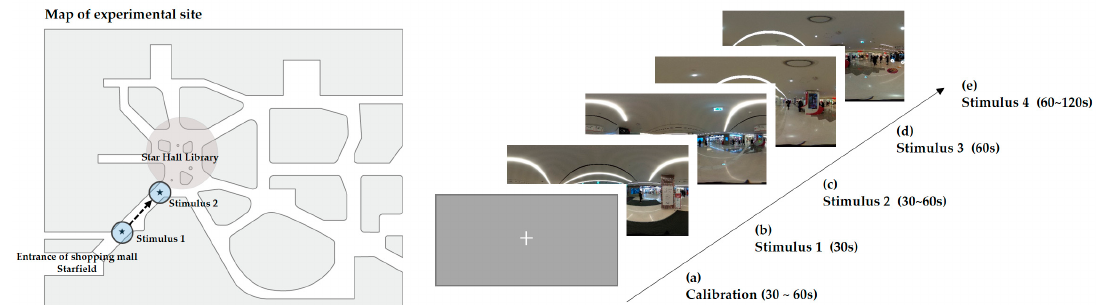
Figure 1. Visual stimuli for experimental procedures with a map of the experimental site. The stimulus images in the diagram are flattened, 360-degree images to indicate the experiment’s setting. ( a ) As a focus adjustment step for extracting the gaze data of each subject, subjects performed the focus data test in a 360-degree space. The images ( b ) and ( c ) show the subjects’ exploration of the surrounding